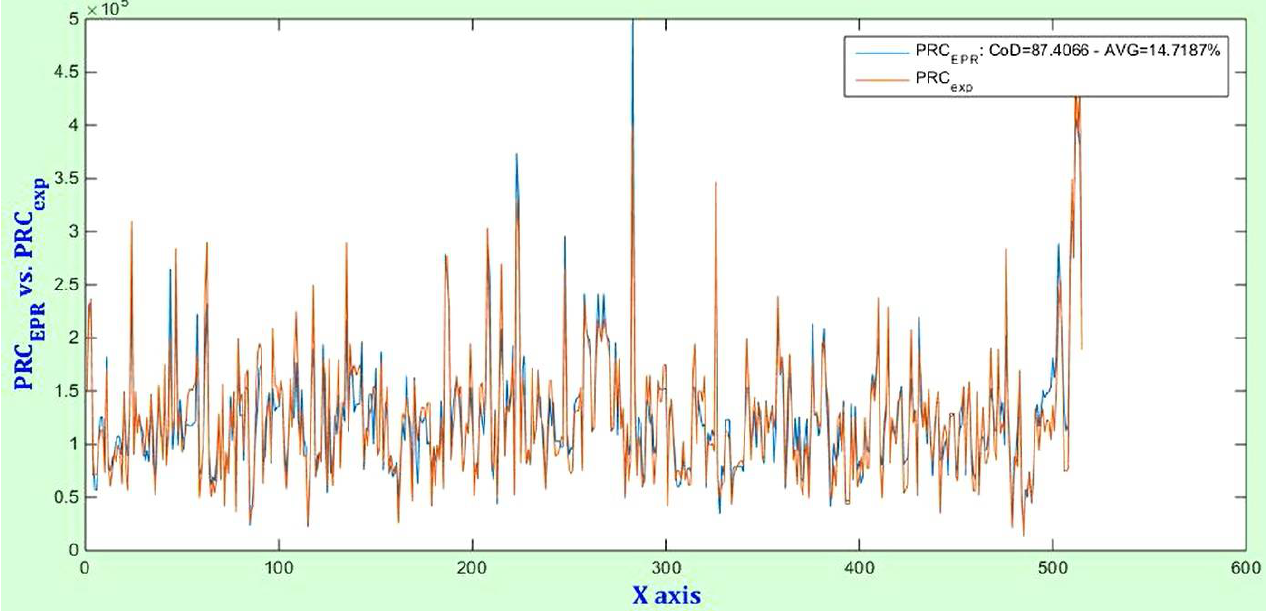
Figure 4. Selling price determined by EPR-MOGA (PRC EPR ) vs. selling price expected for model IV (PRC exp ).